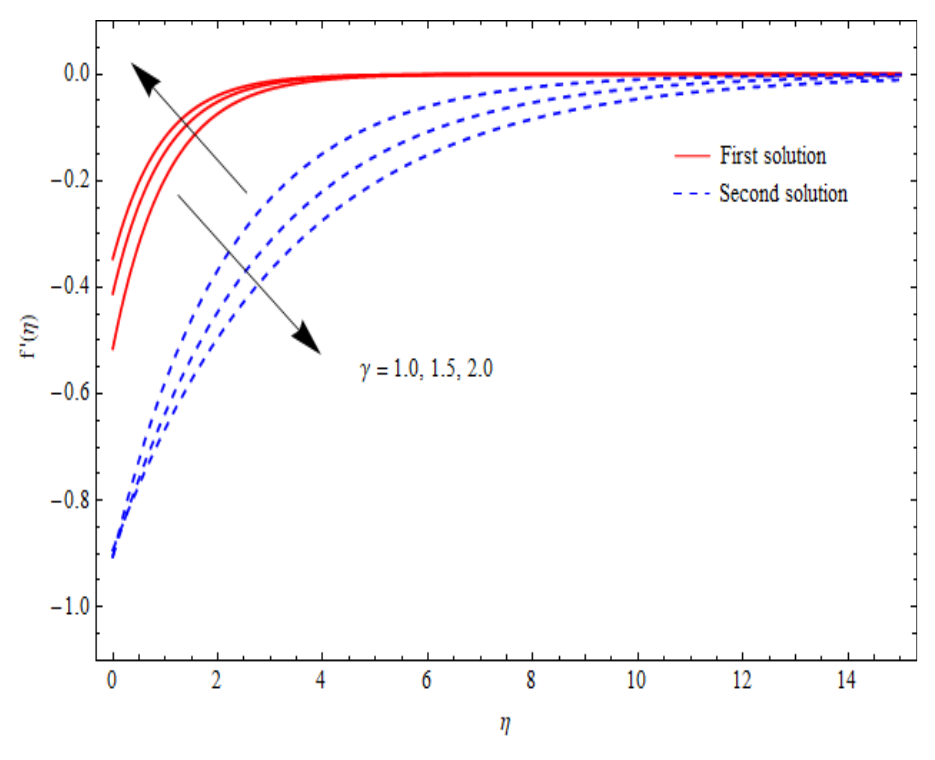
Figure 10. Velocity profiles f (cid:48) ( η ) for distinct γ when λ = − 1.5, k 1 = 1 = s , δ = − 1, ϕ 1 = 0.1 = ϕ 2 .